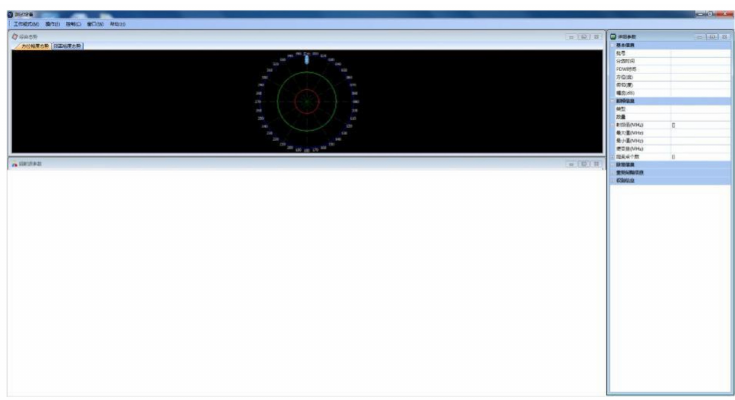
Figure 11. Display terminal interface of the signal reconnaissance